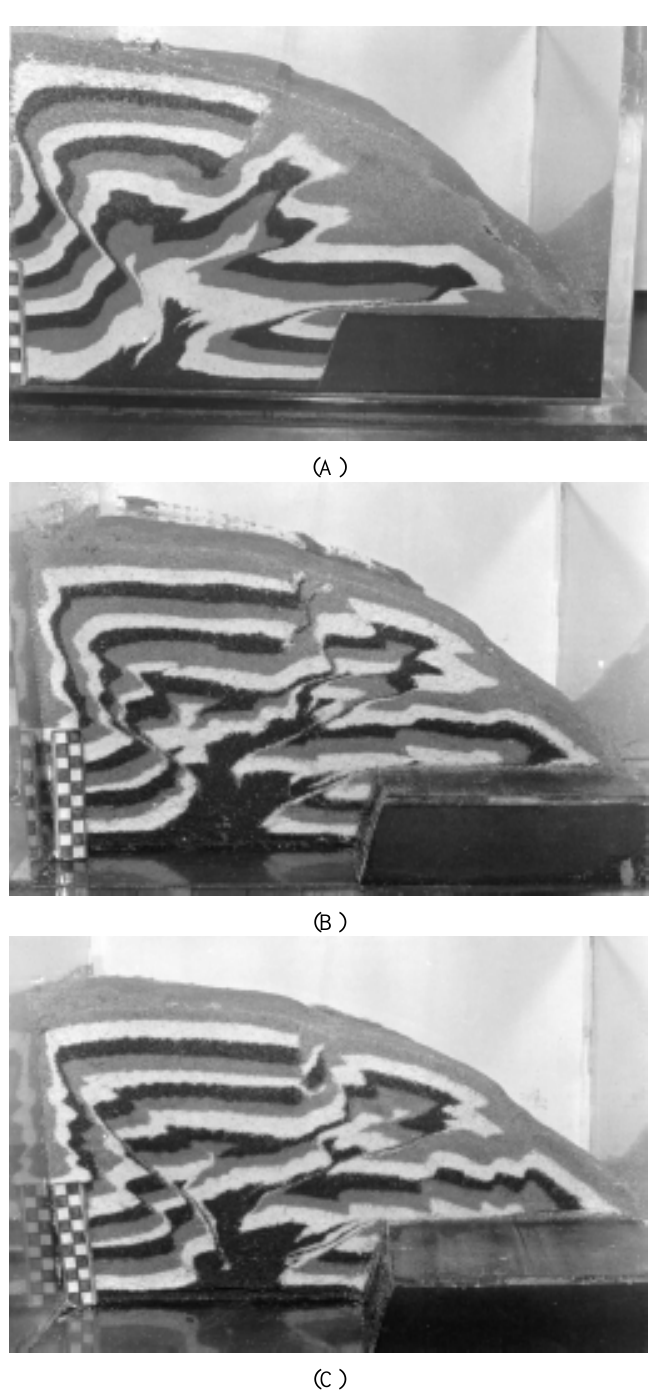
Fig. 5 – Photographs of serial cross sections of model M2-b, at the final stage of 68% shortening, showing an antiformal stack under decreasing influence of side wall friction. A – sideview through the model wall; B – section at 5 cm from the side wall; C – central section (at 10 cm from both side walls). Scale bar is 5